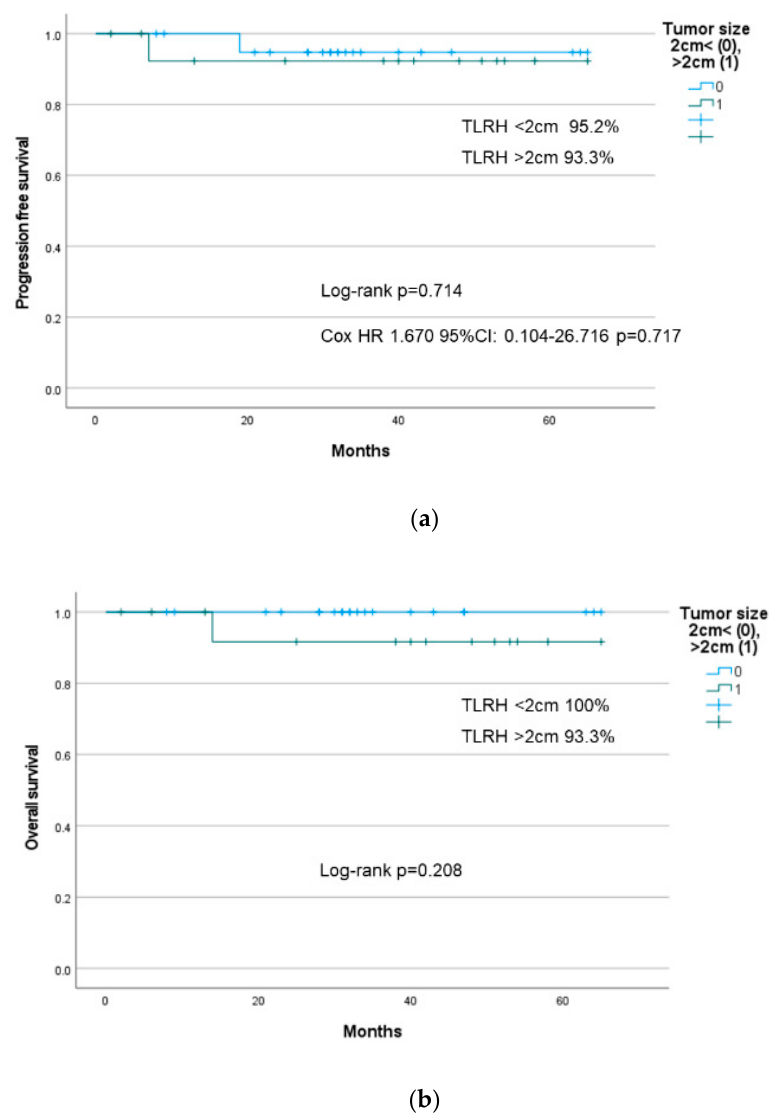
Figure 5. Kaplan–Meier curve for ( a ) progression-free survival and ( b ) overall survival in total laparoscopic radical hysterectomy (<2 cm vs. ≥ 2 cm). Table 3. Analysis of collapsed vaginal cuff in the TLRH group.